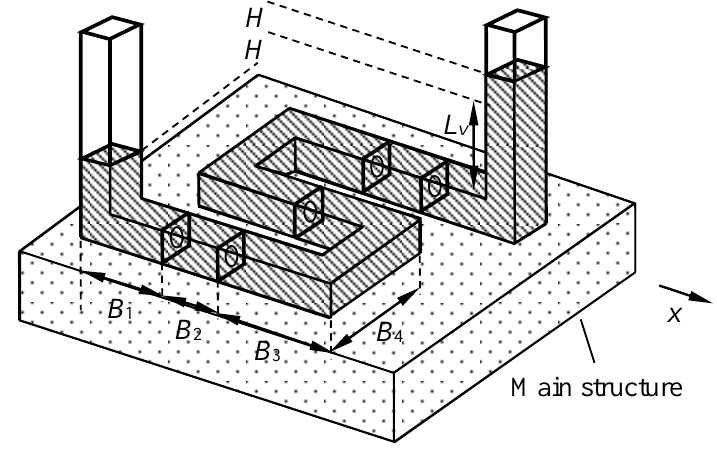
Figure 1. Schematic diagram for an S-shaped